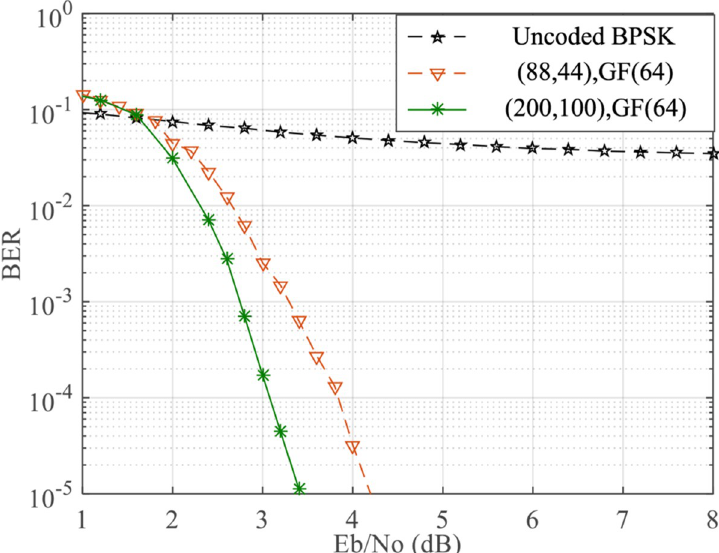
Fig 7. Performance comparison of QC LDPC codes on AWAN channel with A = 0.1 and Γ = 0.1.